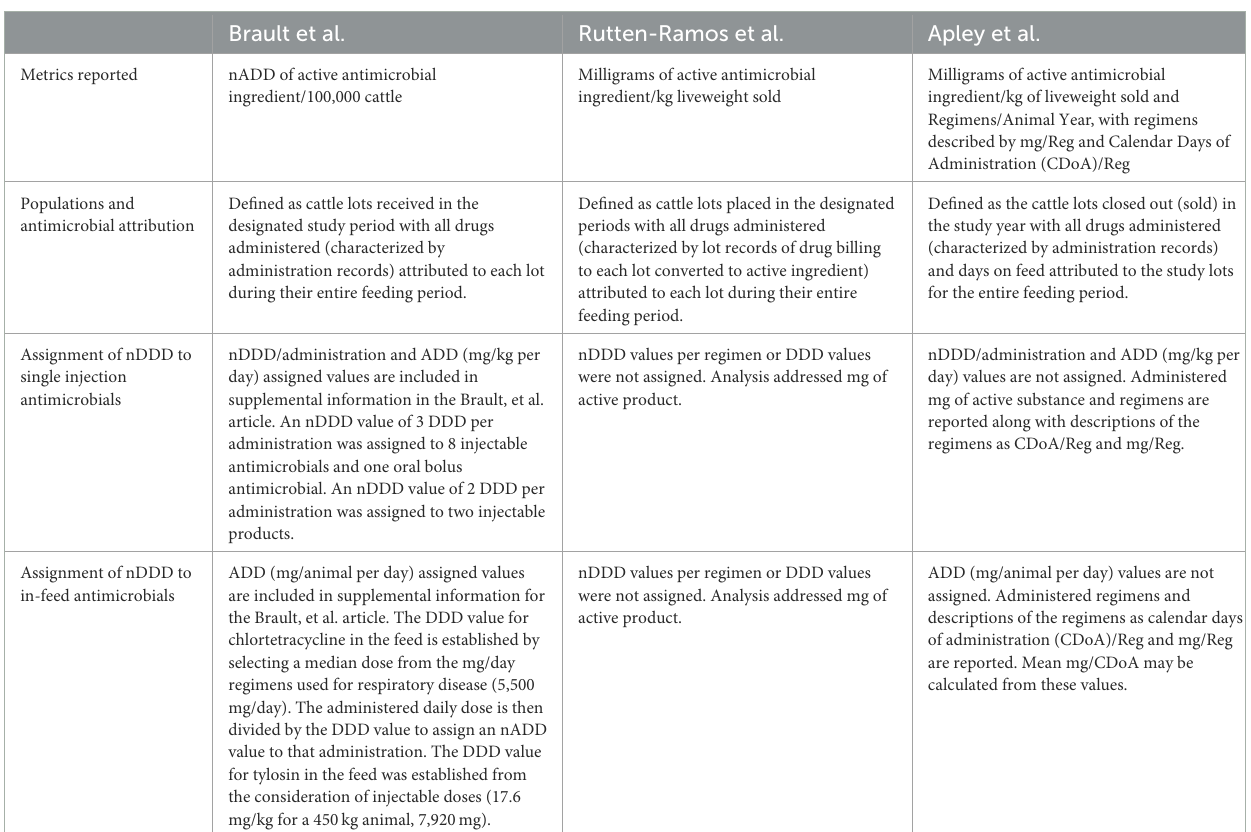
TABLE 13 Characteristics of 3 different papers quantifying antimicrobial use in North American feedyards. Brault et